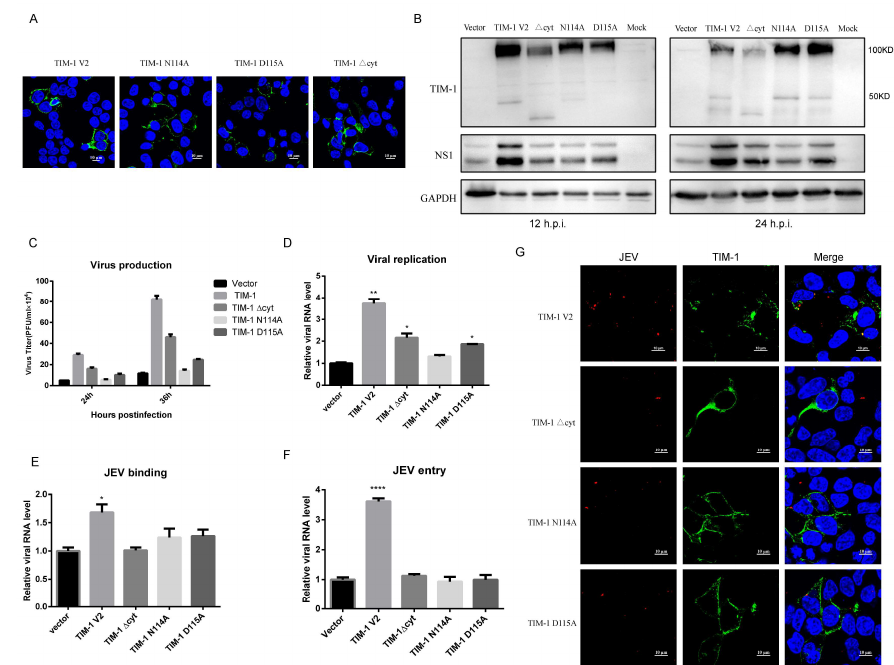
Figure 5. TIM-1 mutants were unable to promote JEV infection. ( A ) Localization of WT TIM-1 and TIM-1 mutants in 293T cells were examined by confocal microscopy. Scale bars, 10 µ m. 293T cells were transfected with WT TIM-1 or TIM-1 mutants encoding plasmids for 24 h, and then cells were challenged with JEV NJ2008 of different MOI; ( B ) cell lysates were collected at 12 h.p.i. (MOI = 5) and 24 h.p.i. (MOI = 1), and JEV infection was determined by Western blot analysis using an NS1-specific monoclonal antibody. One representative experiment out of three is shown; ( C ) supernatants were collected at 24 h.p.i. and 36 h.p.i. JEV progeny production was detected by plaque assay. Data are presented as mean ± SD from three independent experiments; ( D ) total RNA was extracted at 24 h.p.i. and viral replication was determined by qRT-PCR. Data are presented as mean ± SD from three independent experiments using t-test. * p < 0.05, ** p < 0.01; ( E ) cells were incubated with JEV NJ2008 (MOI of 5) at 4 ◦ C for 30 min and then washed with PBS three times. Total RNA was extracted, and the efficiency of JEV attachment was quantified by qRT-PCR. Data are presented as mean ± SD from three independent experiments using t-test. * p < 0.05; ( F ) cells were incubated with JEV NJ2008 (MOI of 5) at 4 ◦ C for 1 h, and then they were washed three times with PBS. They were then shifted to 37 ◦ C for 15 min and treated with proteinase K (1 mg/mL). Total RNA was extracted, and the efficiency of JEV entry was quantified by qRT-PCR. Data are presented as mean ± SD from three independent experiments using t-test. **** p < 0.0001; ( G ) cells transiently expressing TIM-1 and the mutants were challenged with JEV NJ2008 (MOI = 10) for 1 h at 4 ◦ C. They were then shifted to 37 ◦ C for 15 min. Cells were treated with proteinase K (1 mg/mL). Then, they were fixed and stained for E glycoprotein (red) and TIM-1 (green), followed by confocal microscopy analysis. Scale bars, 10 µ